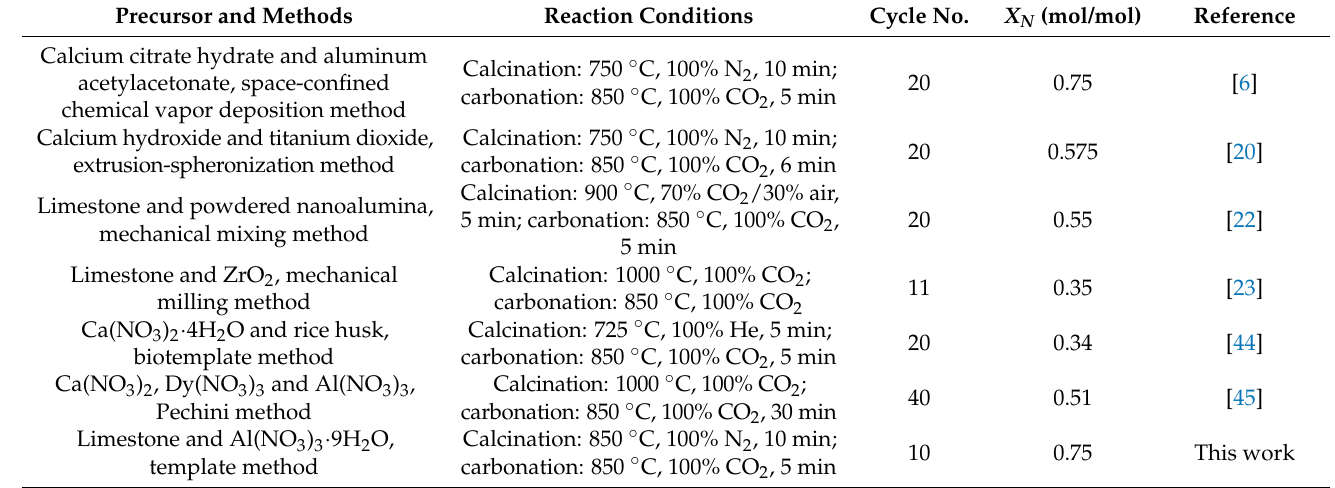
Figure 5. Cyclic carbonation conversions of templated CaO-based materials with different addition amounts of biomass. Table 3. Summary of various synthetic CaO-based energy storage materials in references.